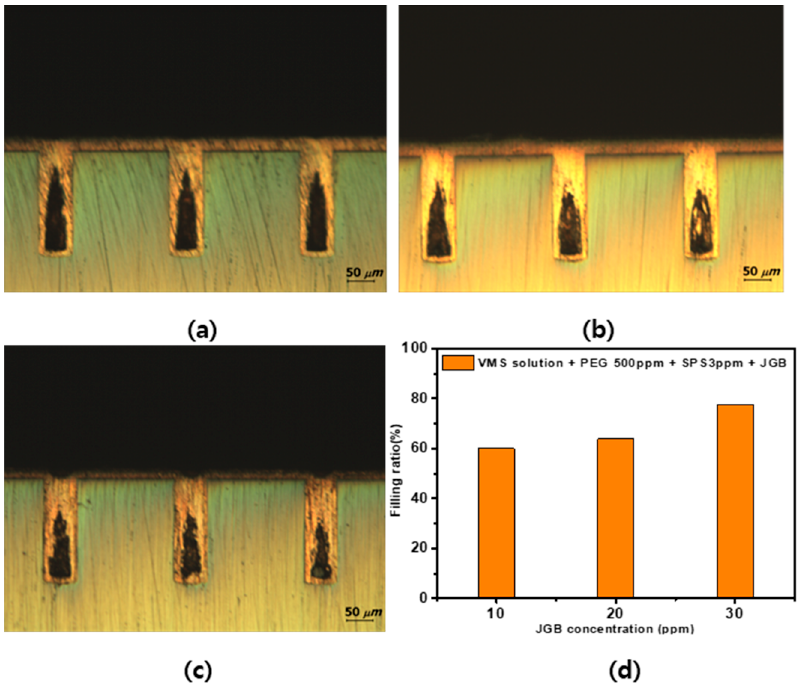
Figure 8. ( a – d ) Images of changing JGB concentration in a VMS bath with 500 ppm PEG and 3 ppm SPS: ( a ) JGB 10 ppm, ( b ) JGB 20 ppm, ( c ) JGB 30 ppm, and ( d ) filling ratio graph for AR 1:3 TSV.